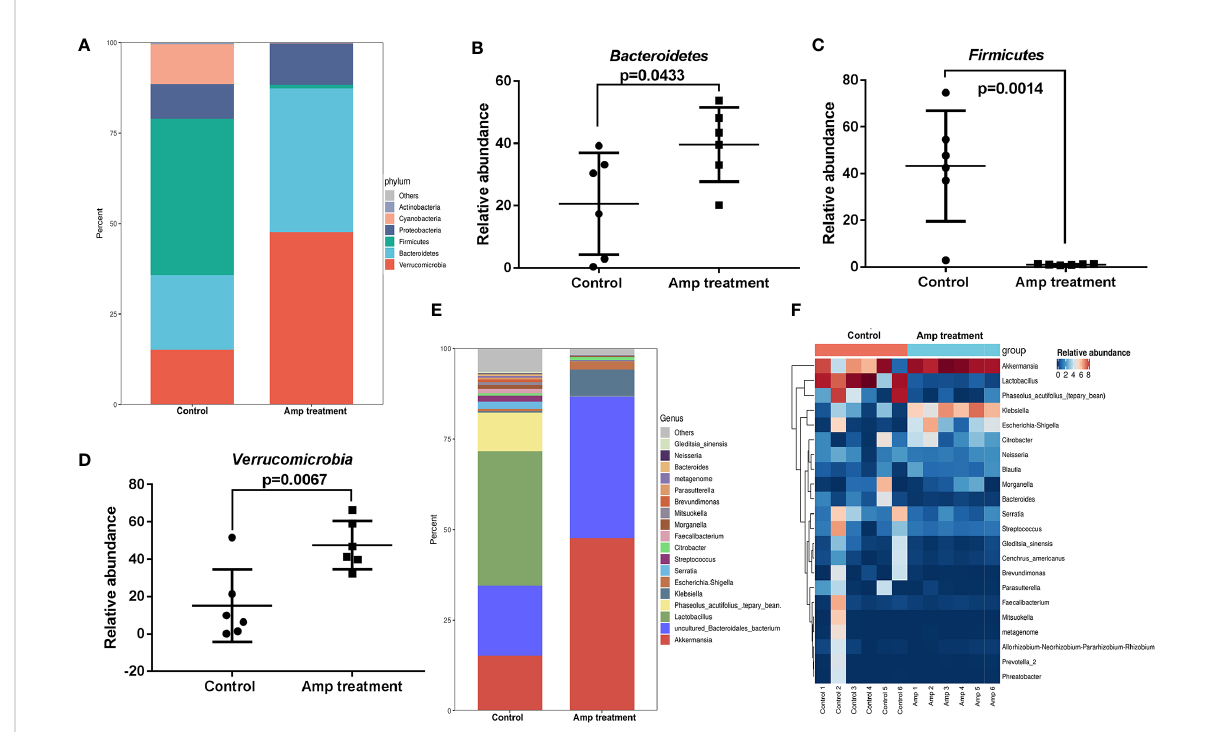
FIGURE 6 Comparison of species composition of intestinal micro fl ora between the two groups at phylum and genus levels. (A) Histograms of intestinal mucosal phylum composition in two groups of mice. (B-D) Scatter diagram of three phyla in intestinal mucosa of two groups of mice. (E) Histograms of intestinal mucosal genus composition in two groups of mice. (F) Heat maps of 20 dominant genus in the two